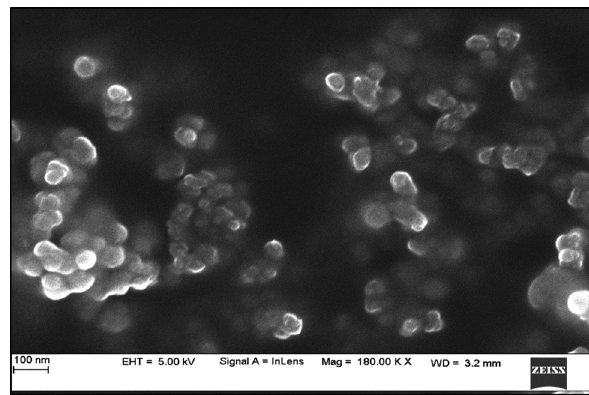
Figure 5: FE - SEM of phyto - fabricated ZnO NPs from S. acuta